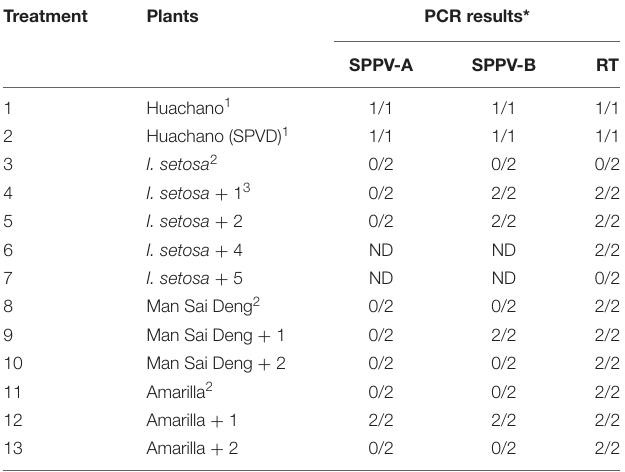
TABLE 3 | Results of graft transmission experiments. Treatment Plants